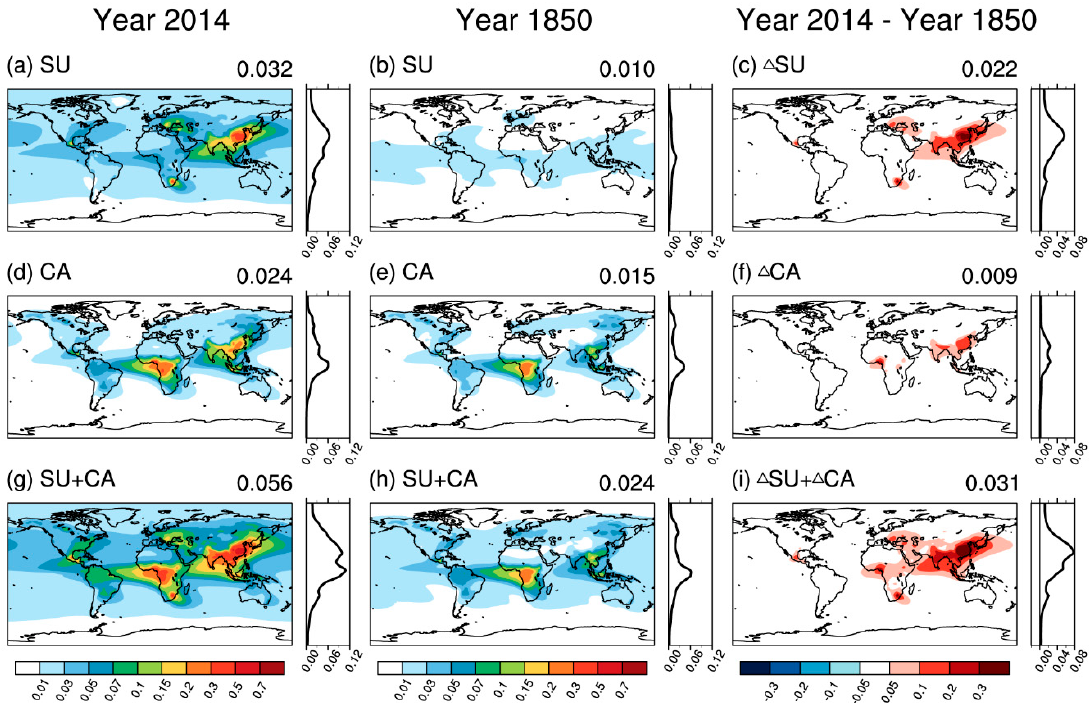
Figure 1. The first row is the modelled annual mean sulfate aerosol optical depth (AOD) in the year 2014 ( a ), the year 1850 ( b ), and the di ff erence between the years 2014 and 1850 ( c ). The zonal means plot is located in the right of each subplot. The global mean value is shown the top right corner of each map, the second row ( d – f ) is same as the first row but for carbonaceous AOD (including pure black carbon and pure organic carbon, internal mixture black carbon and organic carbon), and the third row ( g – i ) is same as the first row but for the sum of sulfate and carbonaceous aerosols AOD. SU = sulfate, CA = carbonaceous aerosol, (cid:52) = the AOD di ff erence between the years 2014 and 1850.